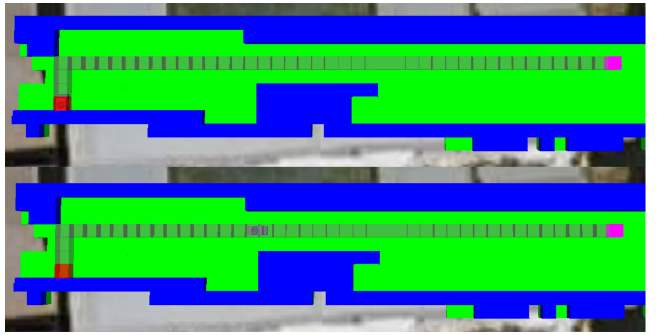
Figure 6. Path Planning Experiment 1, ordinary A* path planning. Blue indicates wall, red indicates starting point, purple indicates the end point, green indicates passable area, grey indicates the path, orange indicates obstacles.